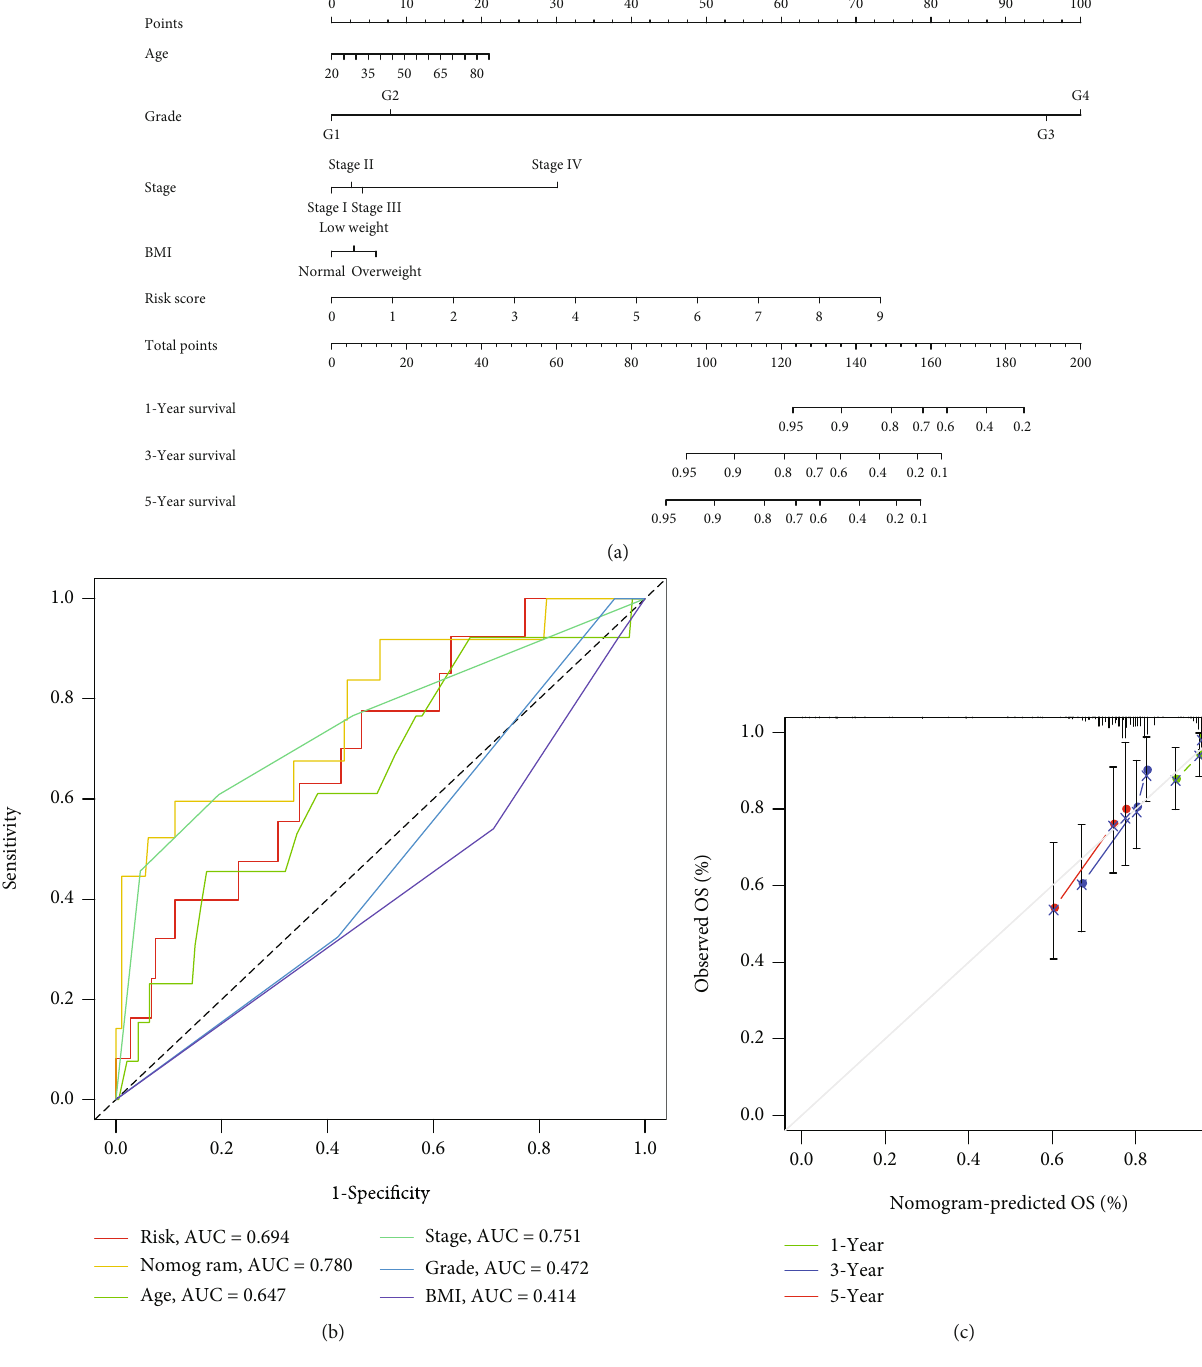
Figure 6: Construction and validation of a prognostic model for cervical cancer patients. (a) Nomogram for predicting cervical cancer patients at 1, 3, and 5 years based on TCGA total cohort. (b) ROC curve containing age, stage, grade, BMI, risk score, and nomogram. (c) Calibration curves for nomogram 1-, 3-, and 5-year predictive power